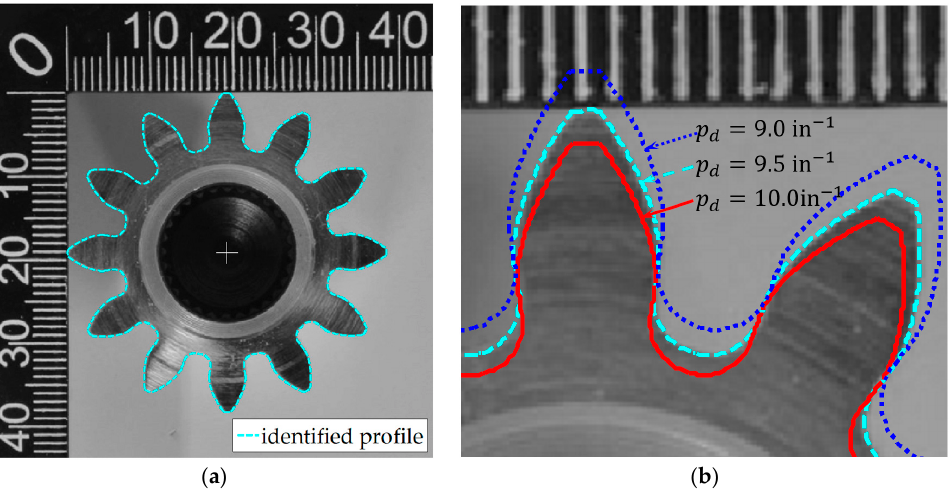
Figure 5. Identified gear profile from an optical image of the gear based on photogrammetry: ( a ) Identified profile and gear center (the cross mark); ( b ) Comparison of the effect on the generated ideal gear profile over three diametral pitch values. By calibrating the pixel width to the reference length on the figure, a conversion coefficient from pixel number to length is found to be 103 pixel/mm.